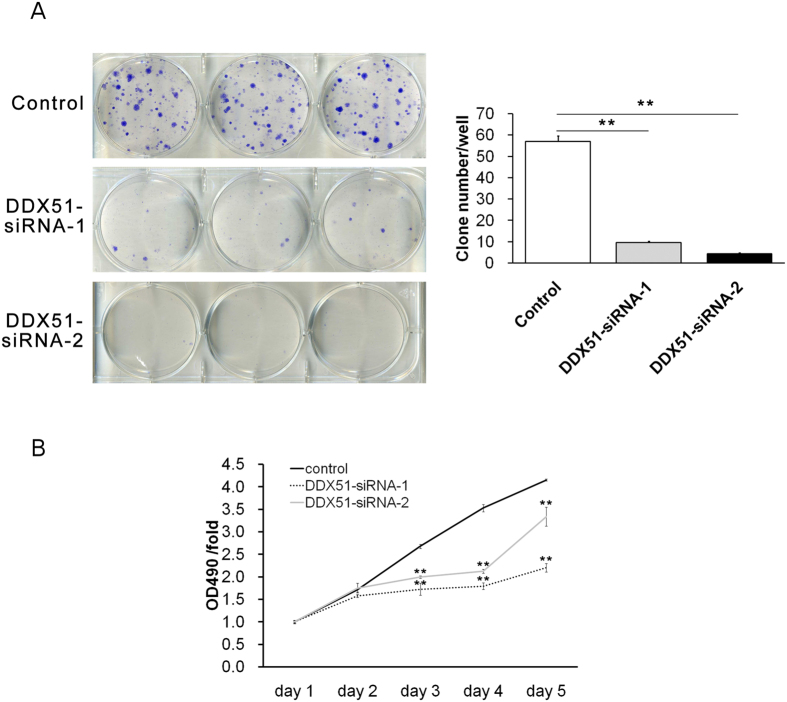
Effects of knocking down DDX51 on colony formation and cell proliferation in H1299 cells.(A) Sample images Giemsa-stained mock transfected and DDX51 siRNA-expressing H1299 cells with quantification. (B) MTT assays were performed in mock transfected and DDX51 siRNA-expressing H1299 cells. Graphs show the mean percentages of three biological replicates. Error bars, standard error. *P < 0.01.